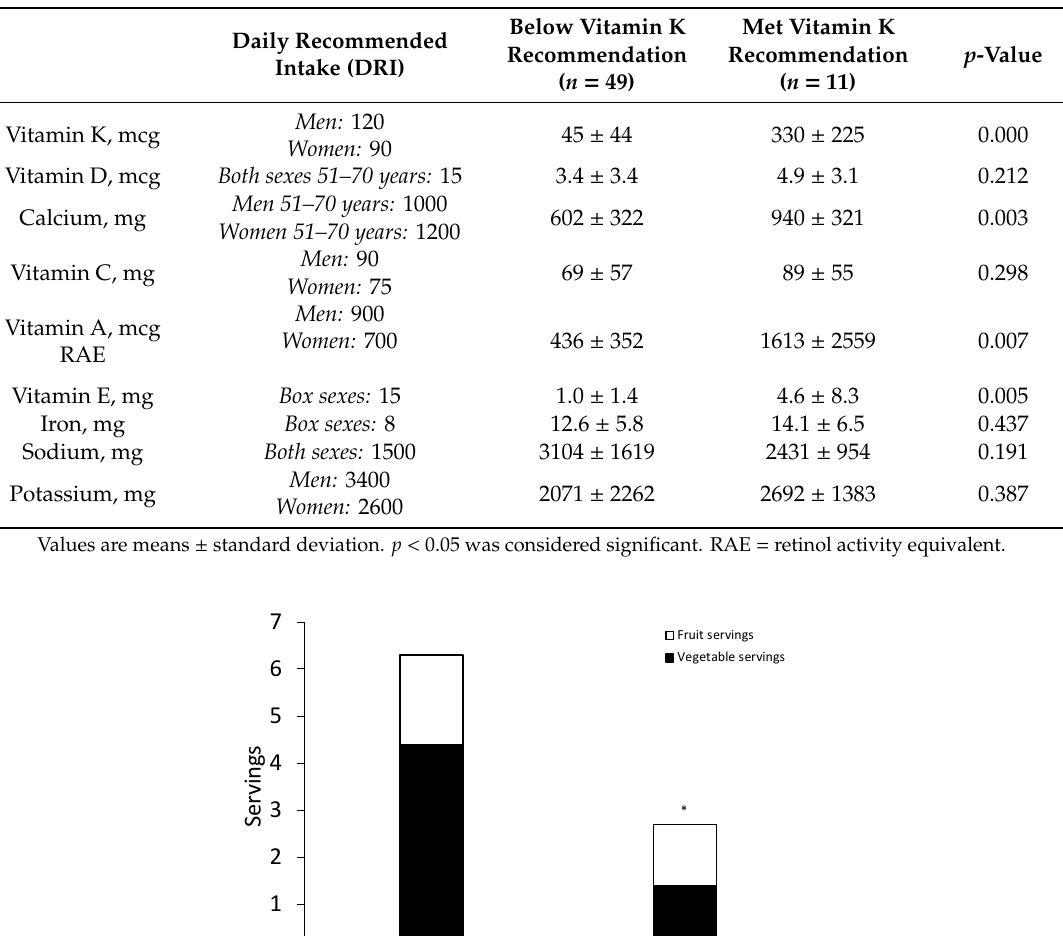
Table 4. Micronutrient and Dietary Reference Intake (DRI) intake.